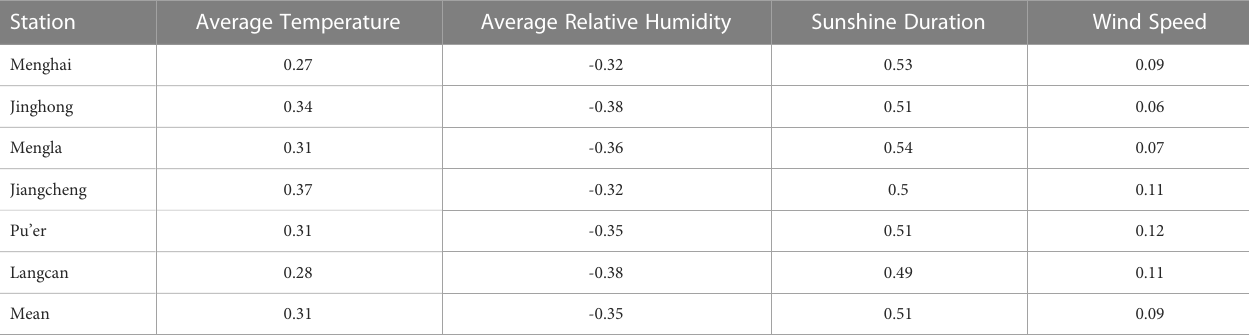
TABLE 5 Correlation coef fi cients of ET 0 and meteorological variables